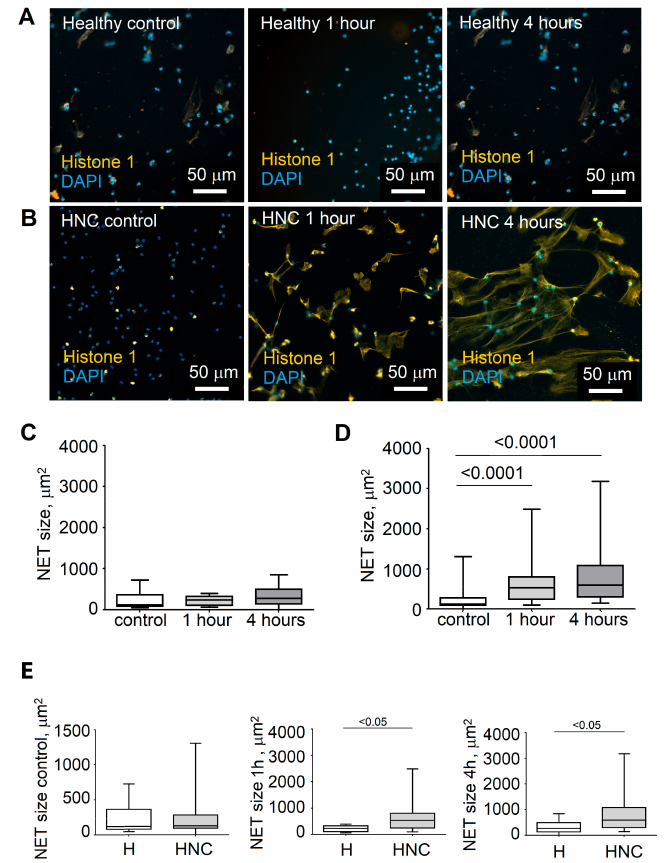
Figure 1. Elevated neutrophil extracellular trap formation in HNC patients. ( A , B ) Representative pictures showing neutrophil extracellular trap (NET) formation by healthy and HNC neutrophils. Isolated neutrophils were incubated with control medium or Pseudomonas aeruginosa for 1 and 4 h, fixed, and stained with DAPI (blue) and anti-histone-1 antibodies (orange); scale bar 50 µ m. ( C ) Quantification of NET size in healthy individuals. ( D ) Quantification of NET size in HNC patients. ( E ) Comparison of spontaneous, early, and late NET release in healthy and HNC individuals. Blood neutrophils of healthy individuals ( n = 10) and HNC patients ( n = 36) were isolated and co-cultured with medium (control) or P. aeruginosa for 1 and 4 h. For comparisons of multiple groups, Kruskal–Wallis ANOVA with Bonferroni correction was used; for comparisons of two independent groups, Mann–Whitney U-tests were used; and for comparisons of two dependent groups, a Wilcoxon matched-pairs signed rank test was used. Data are shown as median, interquartile range, and minimal and maximal